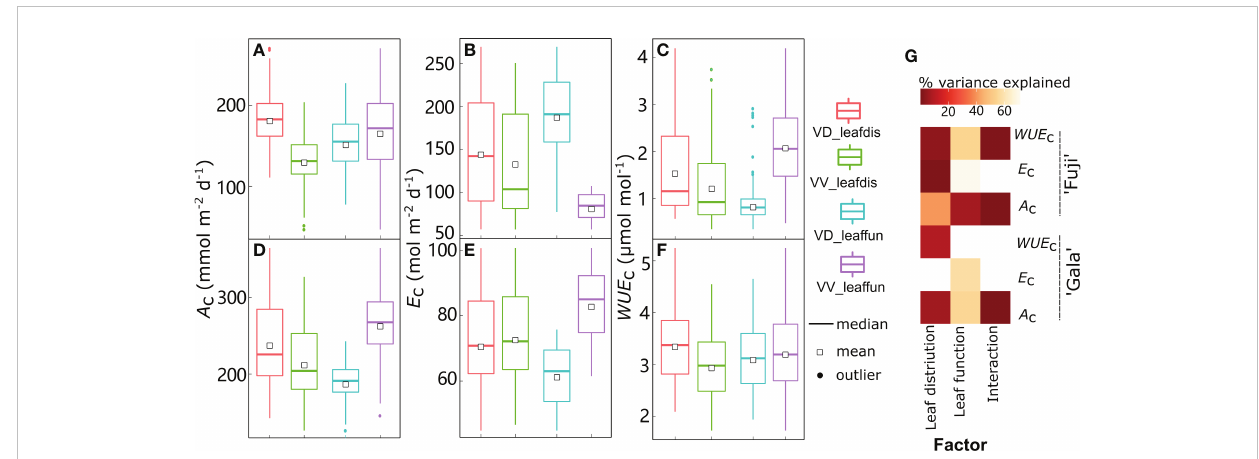
FIGURE 10 Boxplot of daily canopy net photosynthesis rate ( A c ) (A, D) , transpiration rate ( E c ) (B, E) , and water use ef fi ciency ( WUE c ) (C, F) in ‘ Fuji ’ and ‘ Gala ’ trees with switching interstock (dwarf interstock (VD) and vigorous interstock (VV)) leaf distribution ( leafdis ) and leaf function ( leaffun ) under sunny conditions, and the corresponding amount of variance explained by interstock leafdis , leaffun and their interaction (G) . The percent variance explained by each factor in the model is indicated using color for those factors that explain a signi fi cant portion of the variance ( p < 0.05) and different letters indicate signi fi cant differences at p <